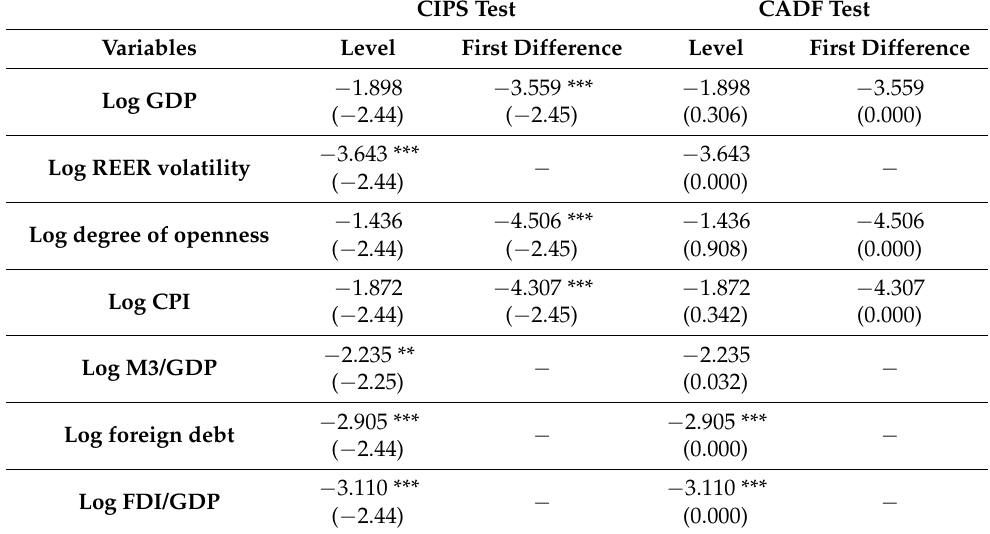
Table 9. Unit Root Test results.